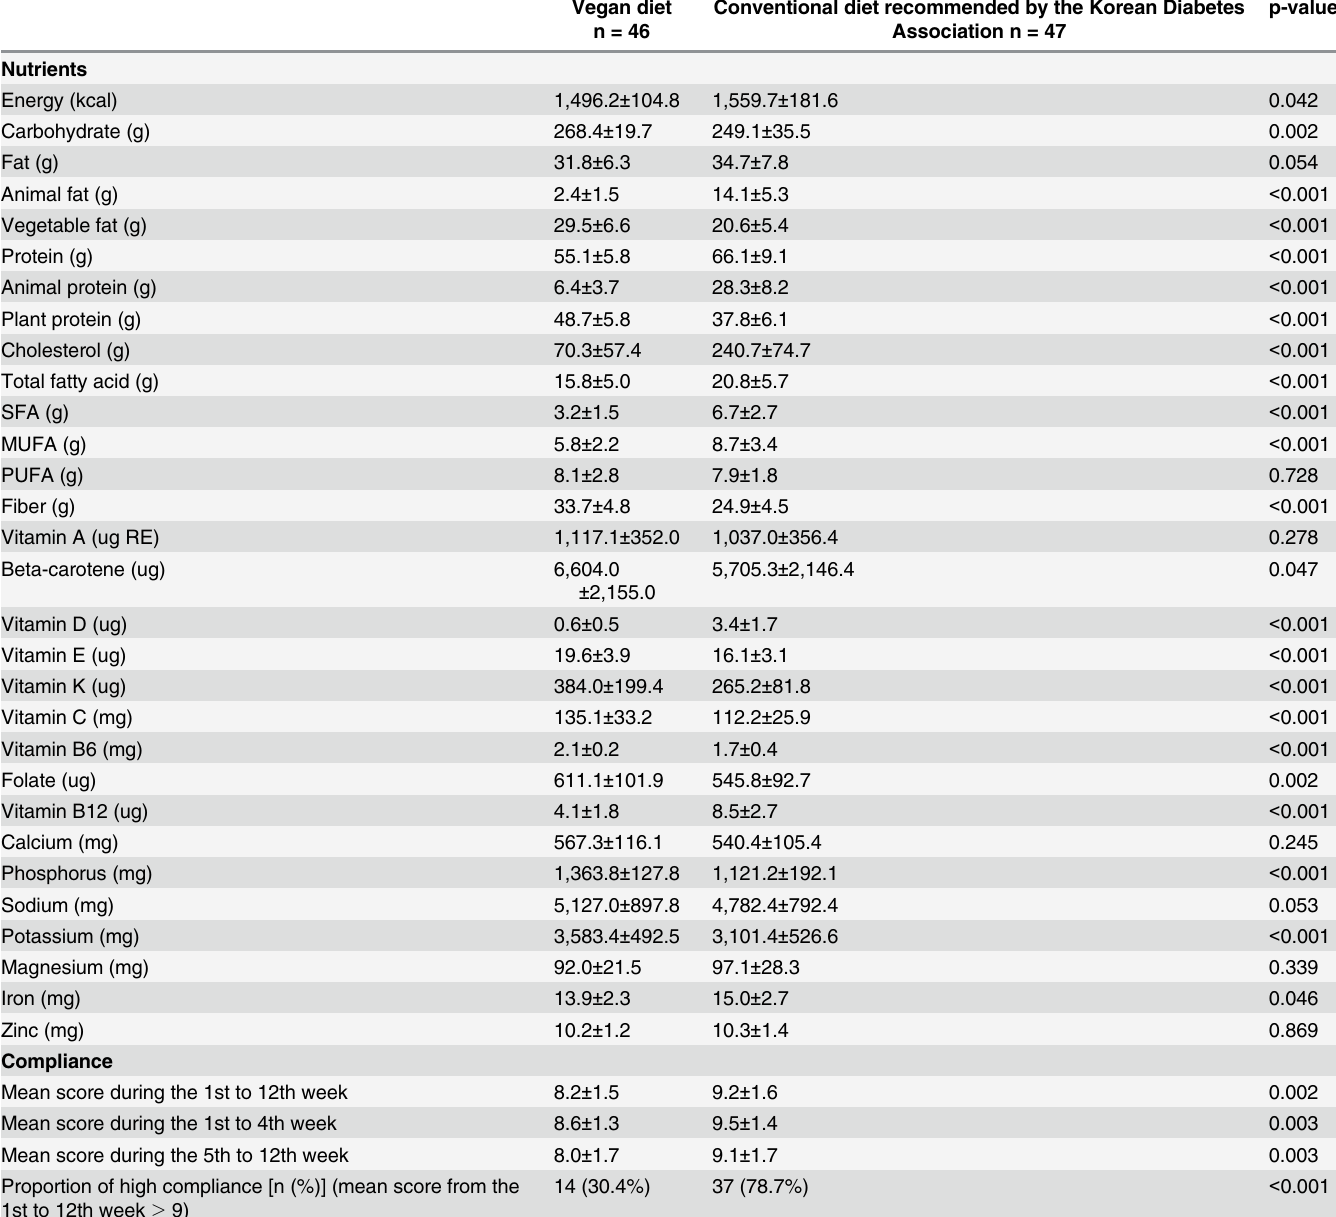
Table 2. Mean nutrient intake status and compliance of the study participants during the 12-week intervention period involving a vegan or conven- tional diet.